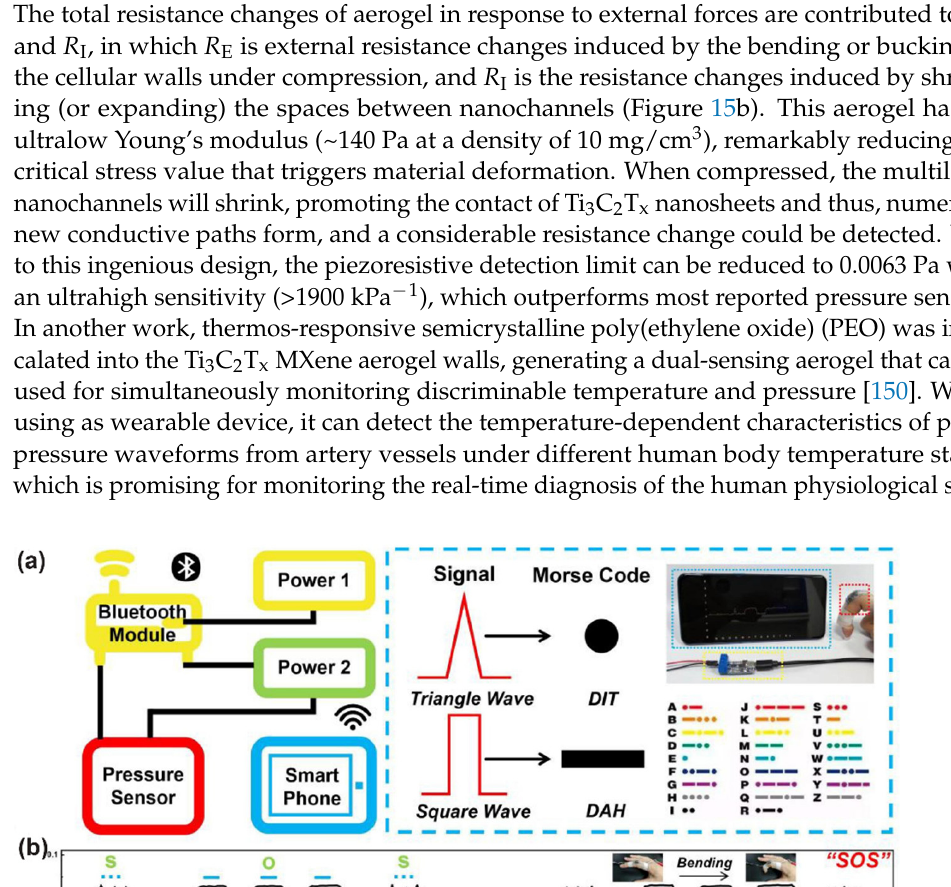
Figure 13. ( a ) Cyclic compressive stress–strain curves and ( b ) finite element analysis of MXene aer- ogel with aligned honeycomb structure. Reproduced with permission from ref. [145]. Copyright 2021, Elsevier.